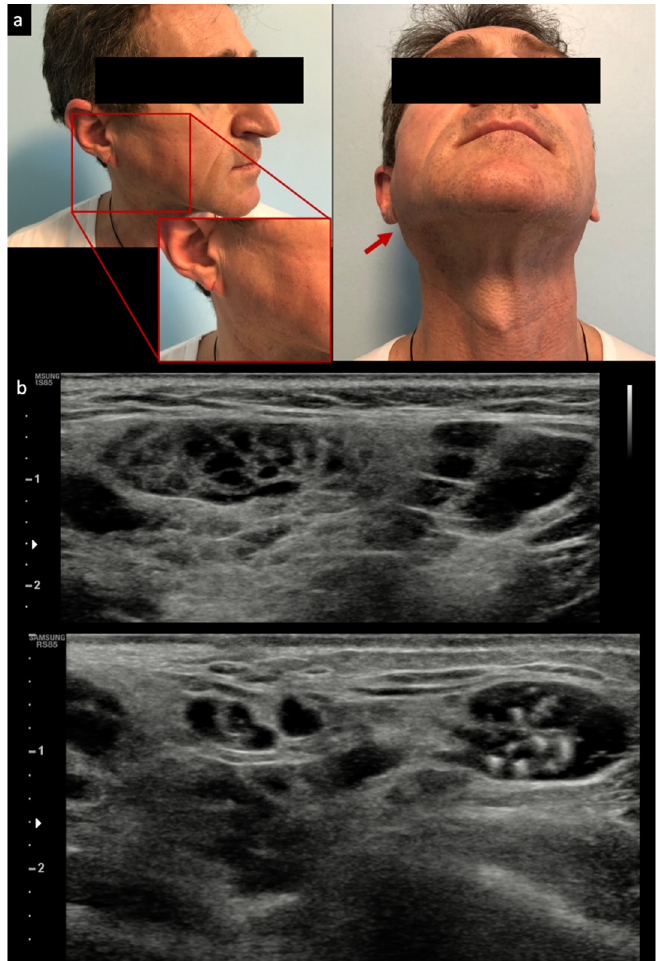
Figure 1. Examples of clinical parotid swelling ( a ) and appearance of mucosa–associated lymphoid tissue (MALT) lymphoma by ultrasound ( b ). Red arrow: Parotid swelling visible after cutaneous inspection.